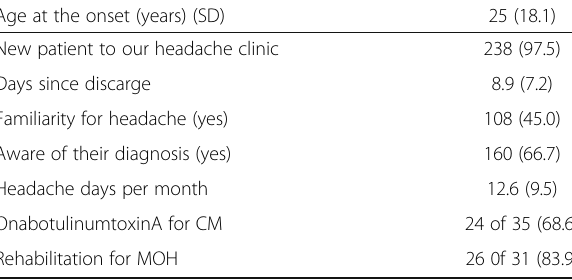
Table 6 Follow-up in the headache